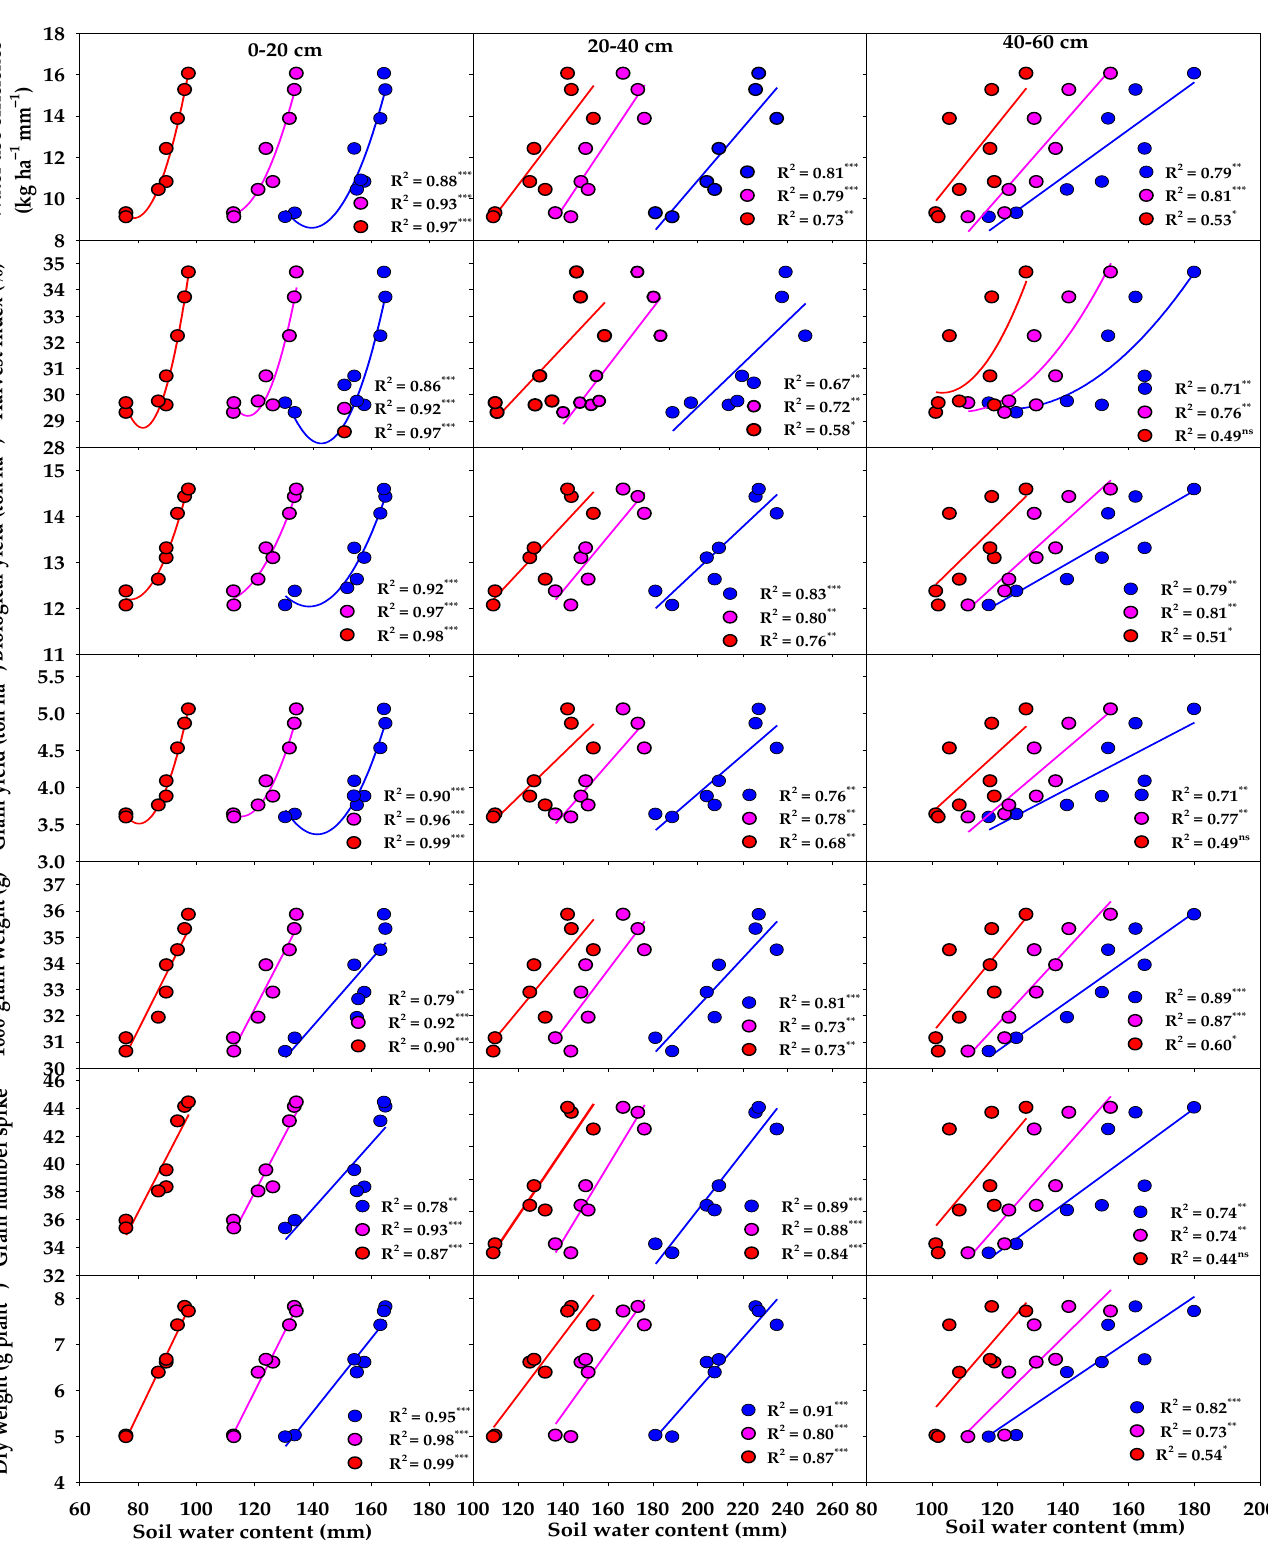
Figure 10. Functional relationship between different plant parameters and the soil water content measured before irrigation at 56 (circle green), 87 (circle pink), and 108 (circle red) days after planting at deferent soil depth under limited irrigation rate (0.50 ET). *,**, and *** indicate significant at p < 0.05, 0.01, and 0.001, respectively; ns indicates not significant.